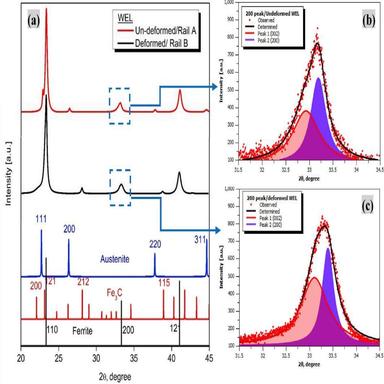
XRD patterns obtained from the two WELs types; rail sample A and B in (a); and 200 reflection profiles obtained from the two WEL types, from sample A in (b) and sample B in (c).